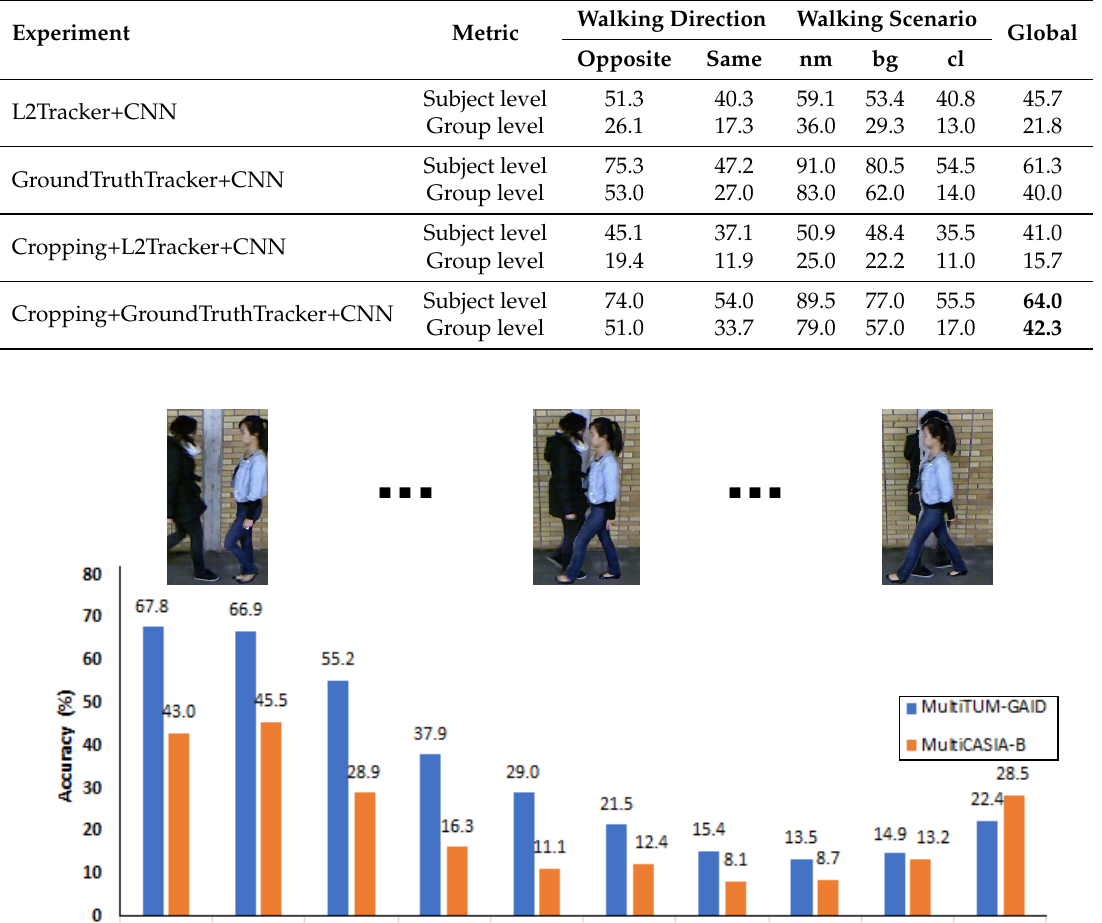
Table 3. Accuracy on MultiCASIA-B. Each row represents a different granularity of the experiment. Each column represents a different test scenario. Best global results are marked in bold. More details in the text.